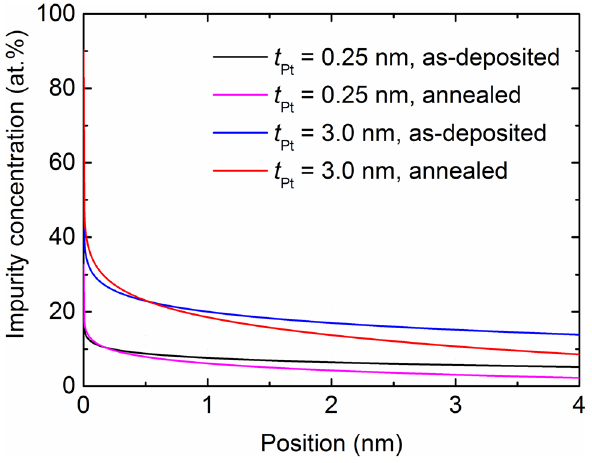
Figure 4. Results for the impurity (Pt or Ru or both) contents as a function of the position in the Co region at Pt thicknesses of 0.2 nm and 3.0 nm in the as-deposited and annealed